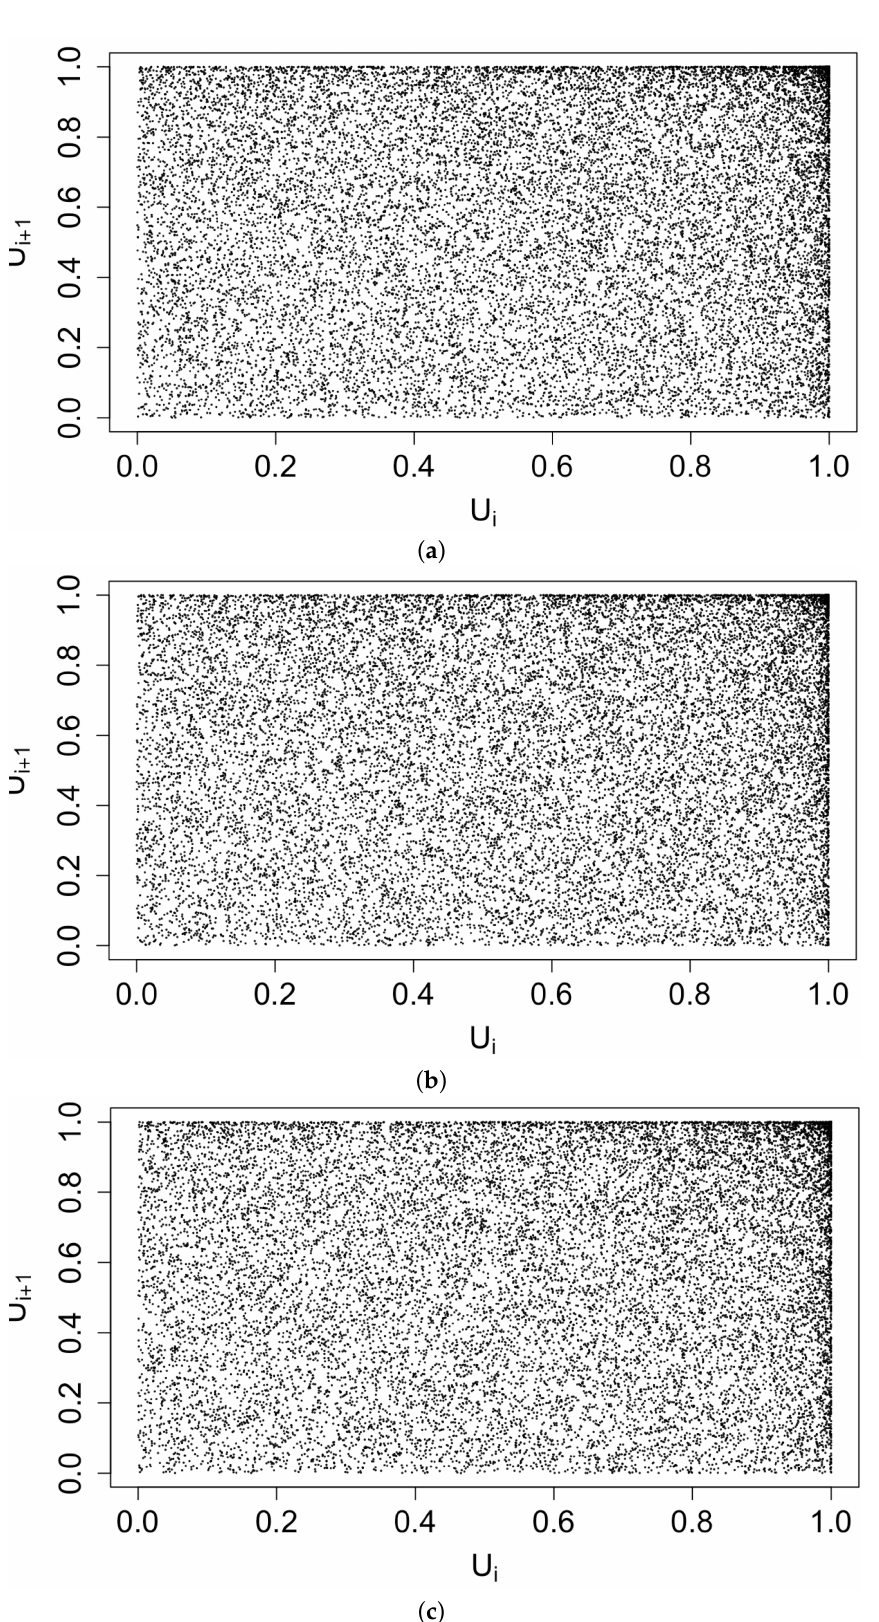
Figure 6. Lag plot of the standardized interevent times u i of the superthinned residuals using b = 100 points/y for ( a ) the Hawkes model with power law triggering, ( b ) the Hawkes model with exponential triggering, and ( c ) the recursive